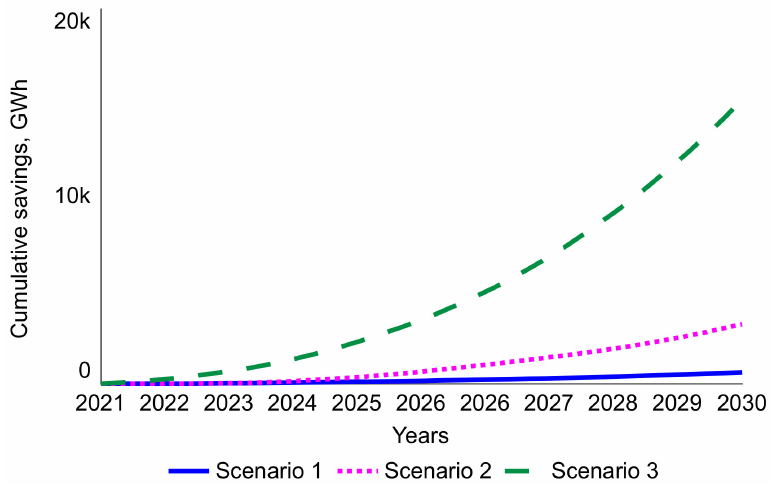
Figure 6. Cumulative energy savings for three policy